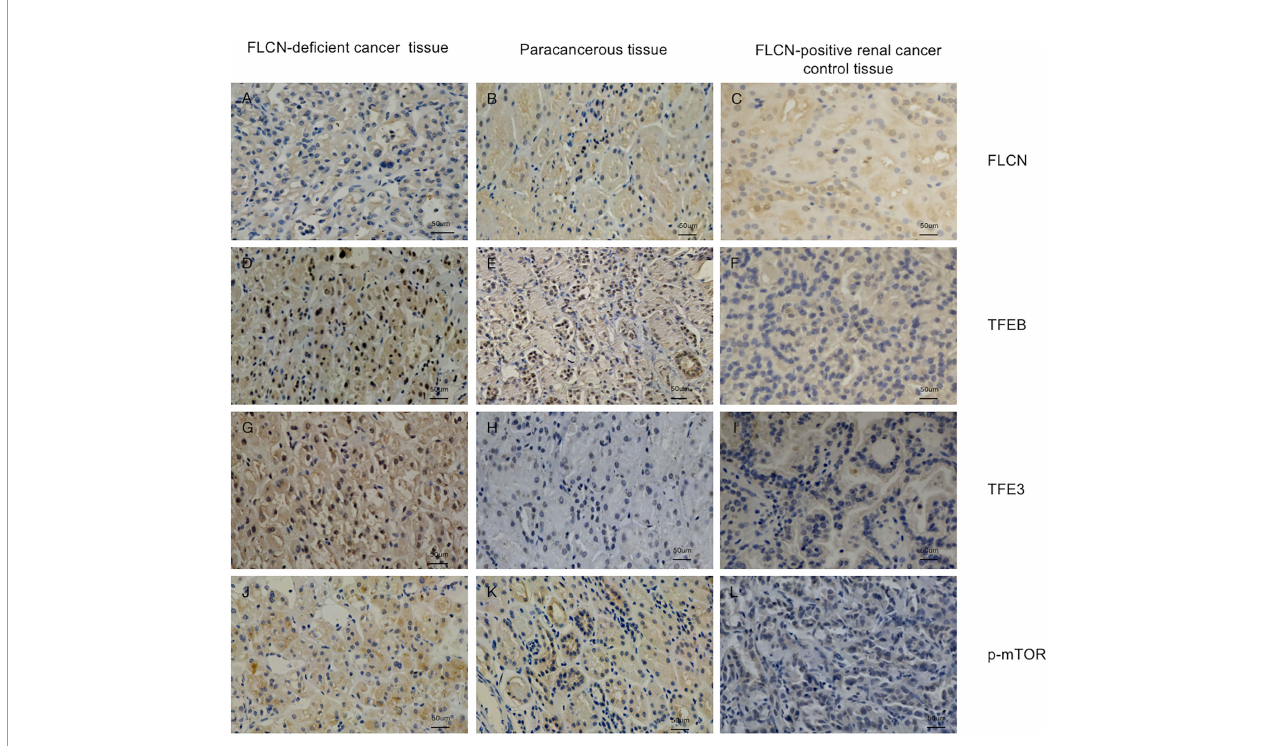
FIGURE 2 | Immunostaining of the patient ’ s tumor tissue (A, D, G, J) and paracancerous tissue (B, E, H, K) and FLCN-positive control cancer tissue (C, F, I, L) . (A – C) Immunostaining of FLCN con fi rmed the loss of FLCN protein expression in patient-derived tumor tissue. (D – F) Immunostaining of TFEB con fi rmed that the protein was constitutively expressed in the nucleus and active in FLCN mutated tissue. (G – I) TFE3 was highly expressed in whole cells of tumor tissue, mainly in the nucleus. (J – L) p-mTOR was highly expressed in tumor and paracancer tissue, but negatively expressed in control